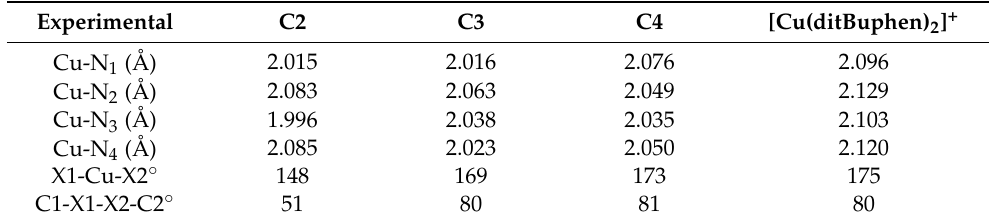
Figure 3. X-ray structures of [copper(I)(2,9-di tert -butylphenanthroline) 2 ] + ( left ) [19] and a repre- sentation of the phenanthroline for analysis in Table 1 ( right ); X n is the centroid of the central phenanthroline ring. Hydrogen atoms and anions omitted for clarity. Table 1. X-ray parameters of C2 , C3, C4 and [copper(I)(2,9-di tert -butylphenanthroline) 2 ] + ([Cu(ditBuphen) 2 ] + ) [19].